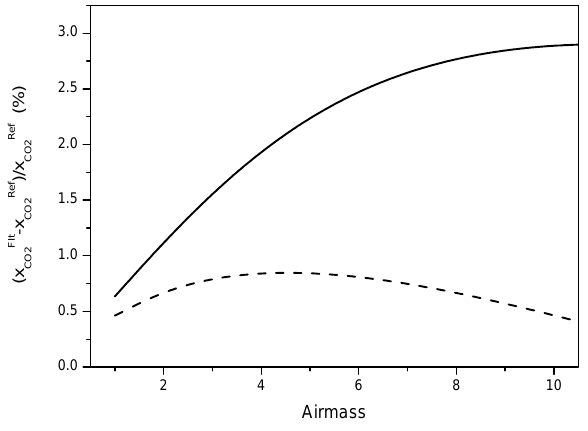
Fig. 5. Relative errors, induced by neglecting LM, in the CO 2 vmr Figure 5. Relative errors, induced by neglecting LM, in the CO 2 vmr deduced from fits of deduced from fits of spectra with a 50cm MOPD for various air- spectra with a 50 cm MOPD for various airmasses. _ _ _ and ___ are values obtained in masses. Dashed and full lines are values obtained in Band#1 by Band#1 by fitting the full region between 4765 and 4915 cm -1 and by restricting the fits to the fitting the full region between 4765 and 4915cm − 1 and by restrict- 4820-4890 cm -1 interval, respectively. ing the fits to the 4820–4890cm − 1 interval, respectively.